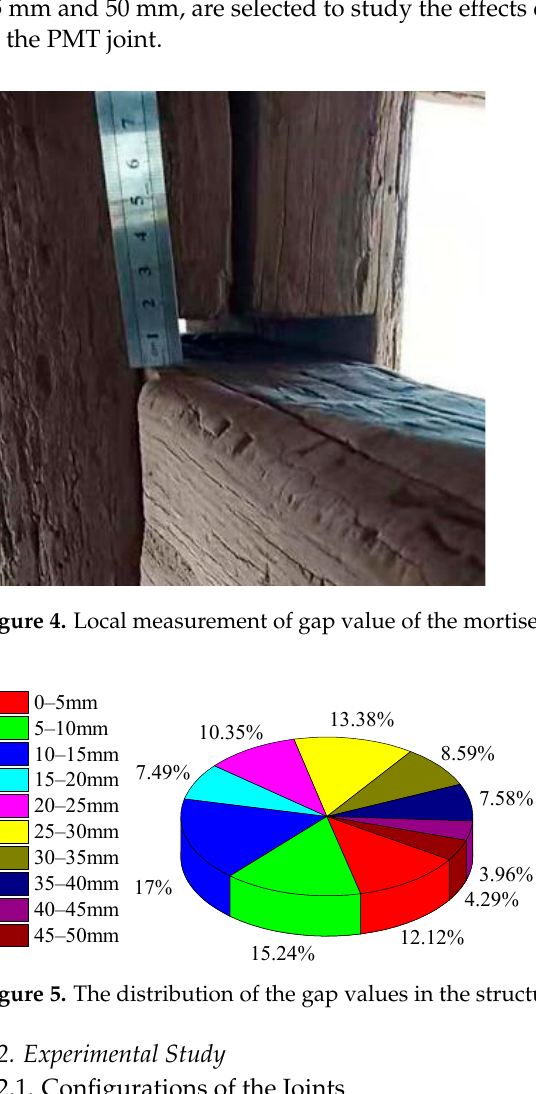
Figure 5. The distribution of the gap values in the structure.